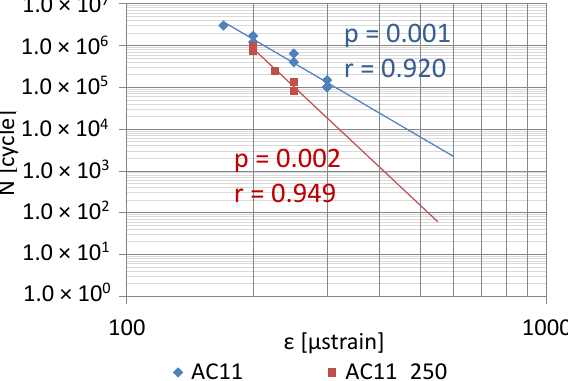
Figure 13. The 4PB stiffness modulus of asphalt concrete AC11 and stone mastic asphalt SMA8 with PMB45/80-55 binder before and after heating for 1h, at a temperature of 250 °C.